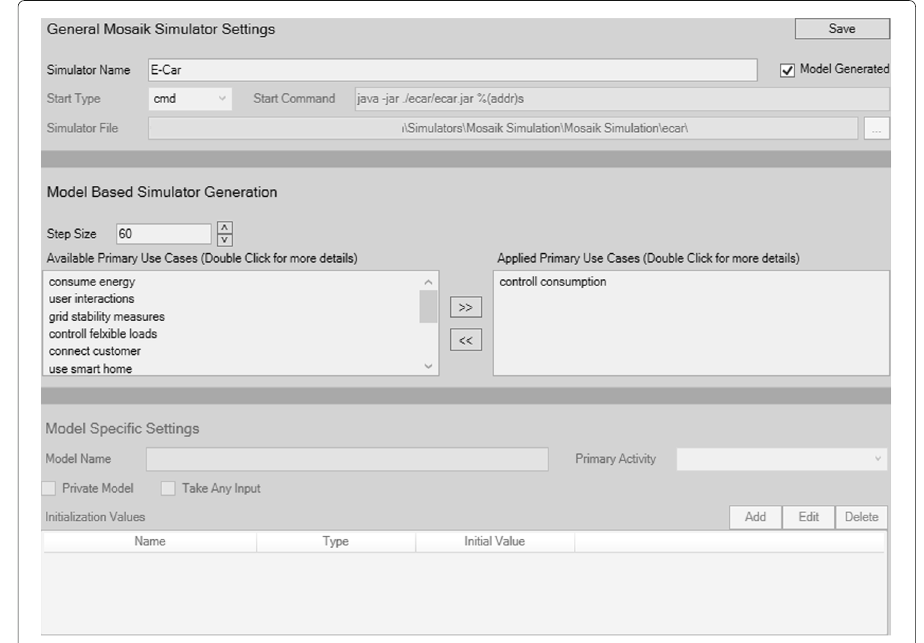
Fig. 4 Simulator Configuration User